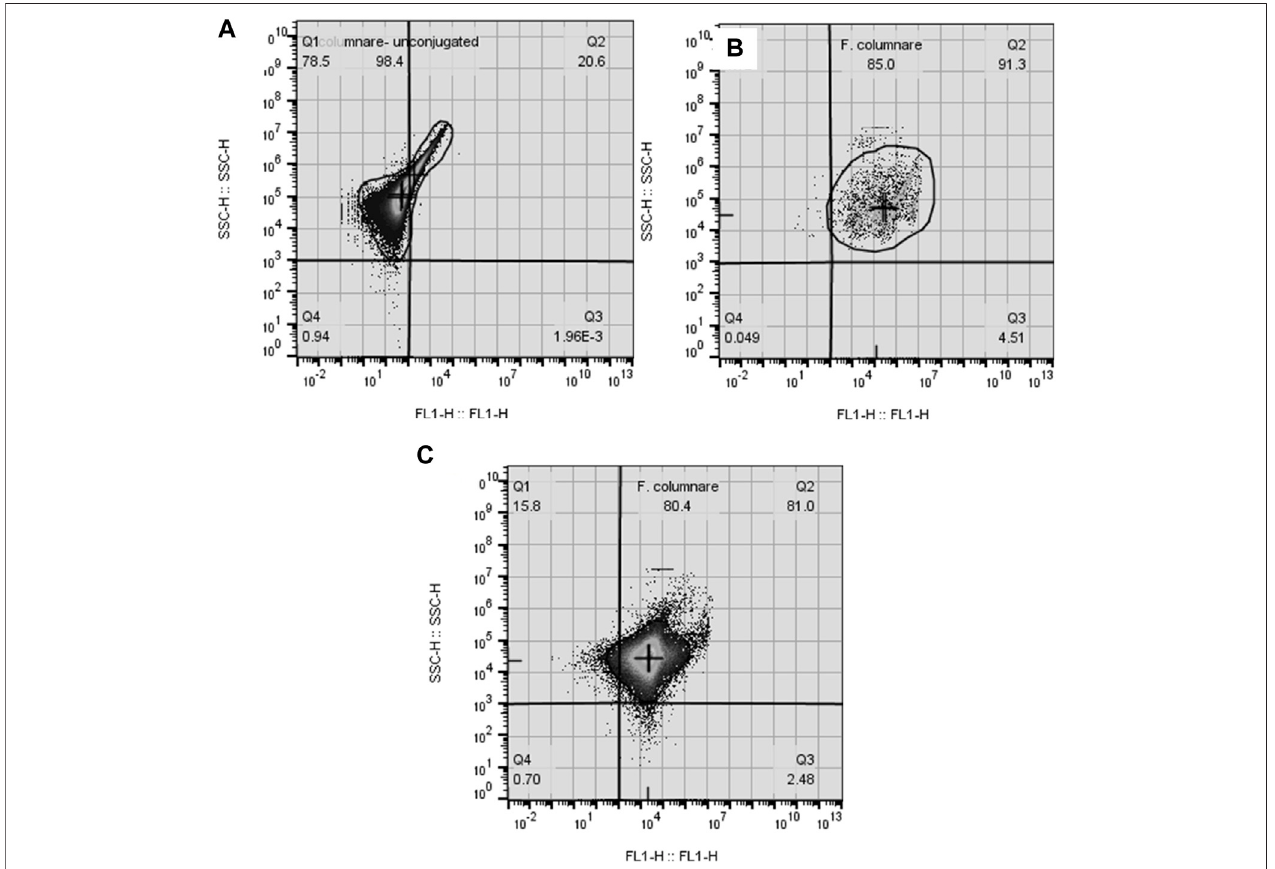
FIGURE 3 | Cytograms depicting fl uorescence density plot (FL1-H vs. SSC-H) of (A) unconjugated F. covae cells obtained from bacterial cell culture and F . covae cell samplesconjugatedwith fl uoresceinlabelled antibodies from (B) control tankscontainingwellwaterand (C) columnarischallengetanks where fi shwereexposedto F. covae . Plots (B,C) show a shift in fl uorescence to the right side of the plot indicating fl uorescence of the conjugated antibody attached to F. covae cells.